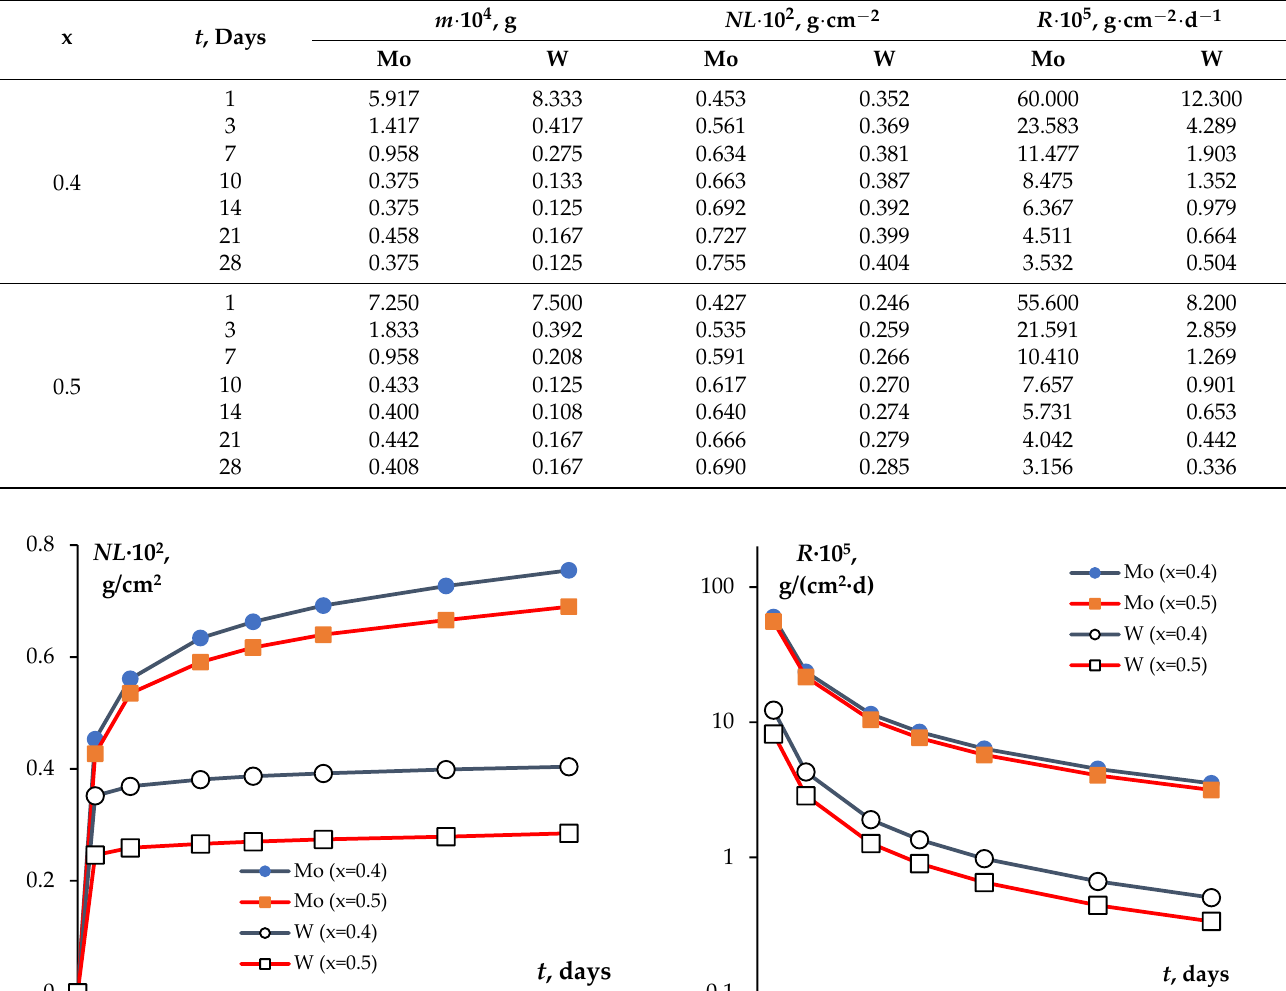
Table 1. Normalized weight loss ( NL ) and normalized leaching rates ( R ) after 28 days of testing for Mo and W in the Na 1 − x Zr 2 (PO 4 ) 3 − x (XO 4 ) x ceramics.